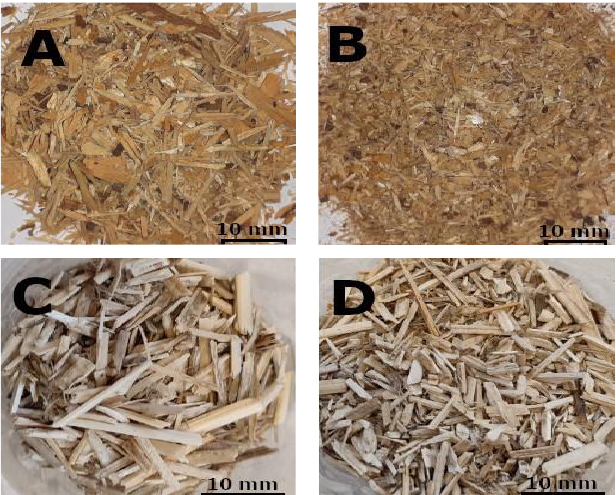
Figure 1. Particle size for each layer of the board: ( A ) industrial particles for the core layer, ( B ) industrial particles for the surface layers, ( C ) hemp shives for the core layer, ( D ) hemp shives for surface layers.